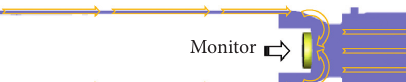
Monitor Figure 8: Position of monitor in the head end.